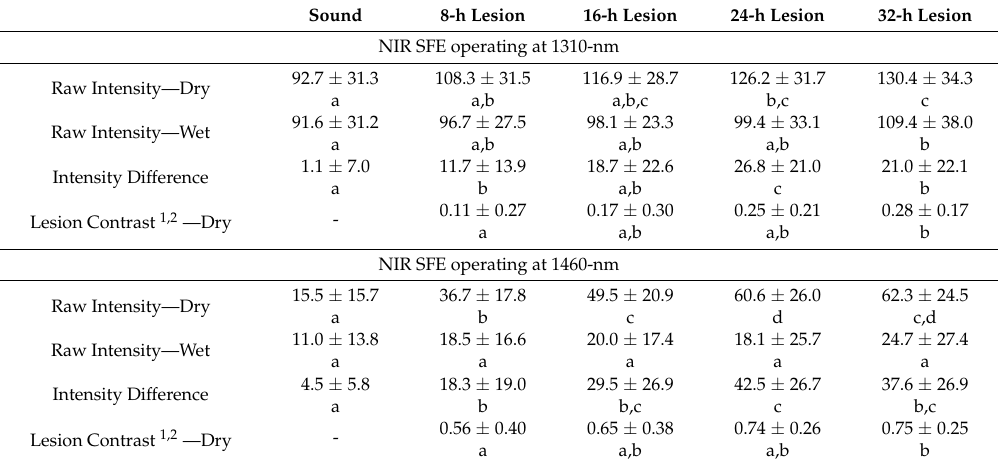
Table 2. Mean ± S.D. for raw intensity, intensity difference between dry and wet images, and lesion contrast values from NIR SFE measurements. Groups with the same letters are statistically similar, p > 0.05 in each row (n = 100).